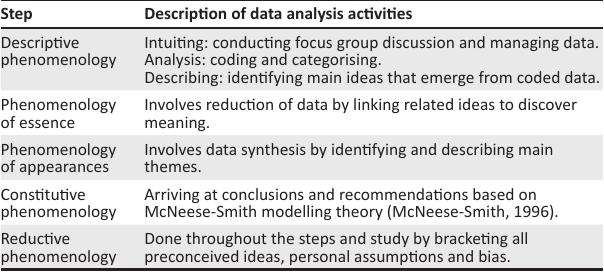
TABLE 1: Five phenomenological steps for qualitative